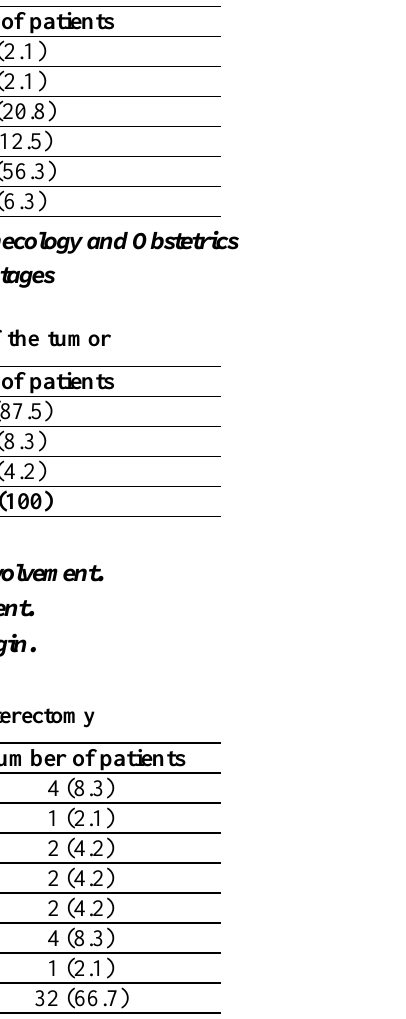
Table IV : Clinicopathological FIGO staging of patients with cervical cancer